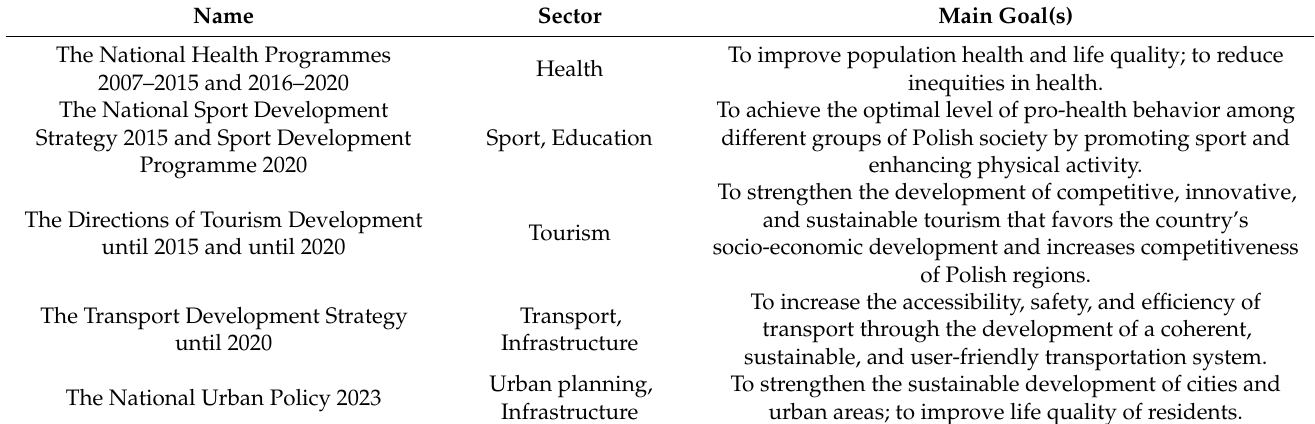
Table 3. Key PA policy documents in Poland.